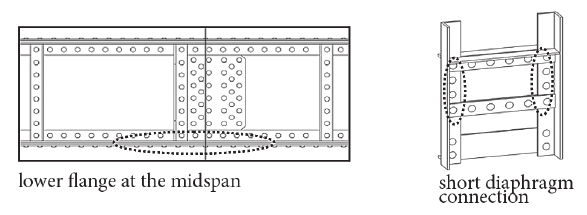
Fig. 7 . Bridge details